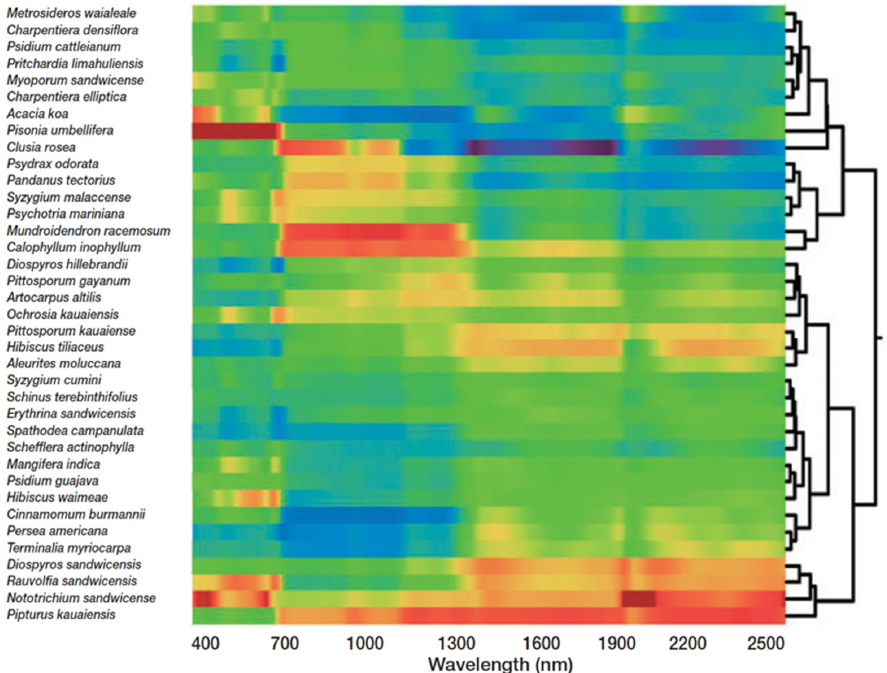
Figure 2. A cluster analysis of the unique spectral signatures of rainforest species in the Hawaiian Islands. The colors represent spectral signatures or the reflected light of each species from 400 to 2500 nm. Yellows–reds and greens–blues show high and low reflectance, respectively [36].